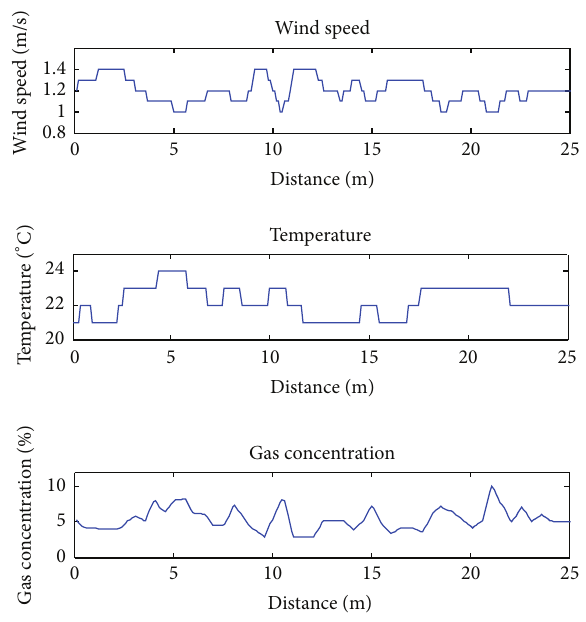
Figure 5: Wind speed, temperature, and gas concentration data from the coal mine